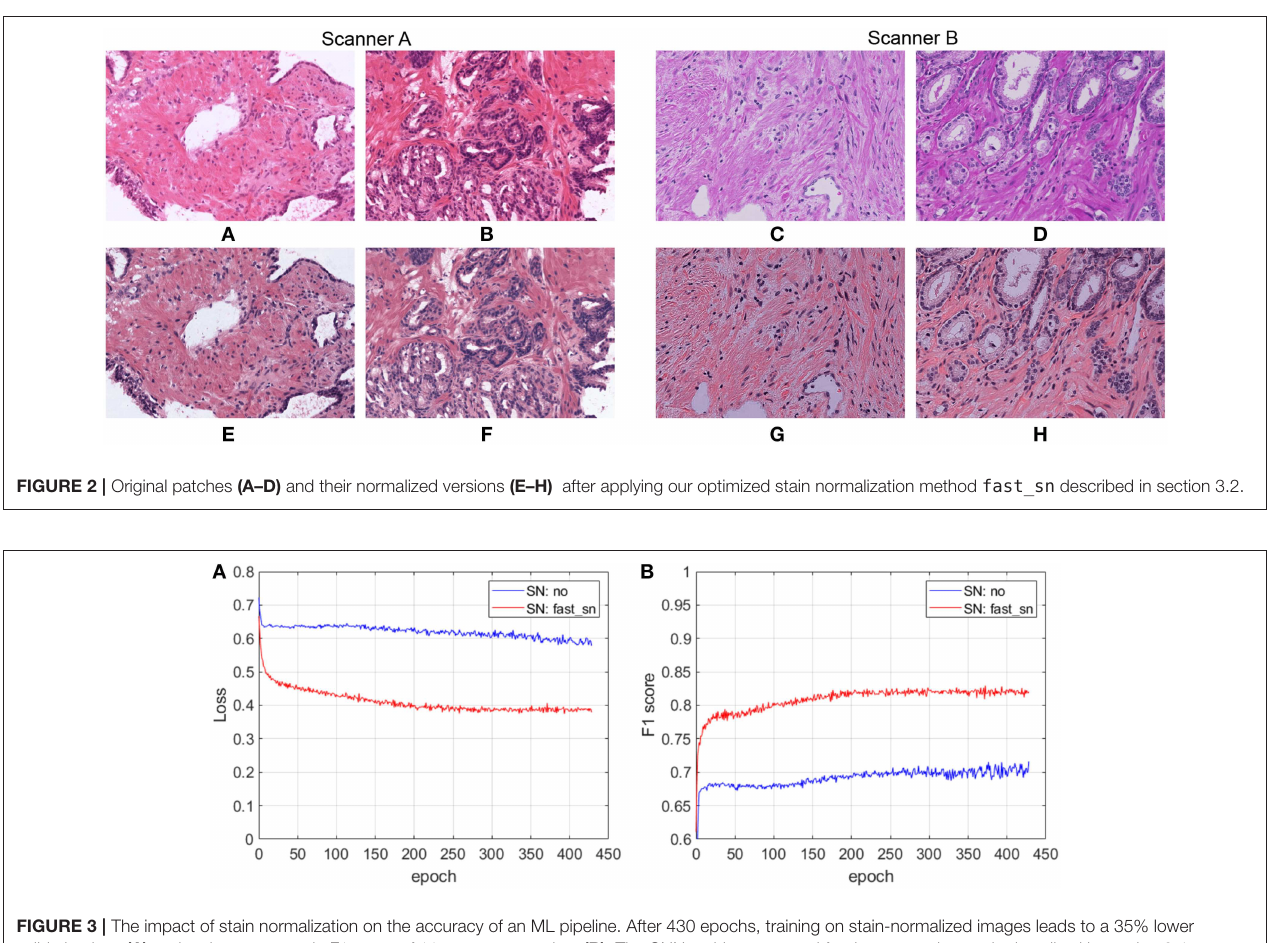
FIGURE 3 | The impact of stain normalization on the accuracy of an ML pipeline. After 430 epochs, training on stain-normalized images leads to a 35% lower validation loss (A) and an improvement in F1 score of 11 percentage points (B) . The CNN architecture used for these experiments is described in section 3.4.